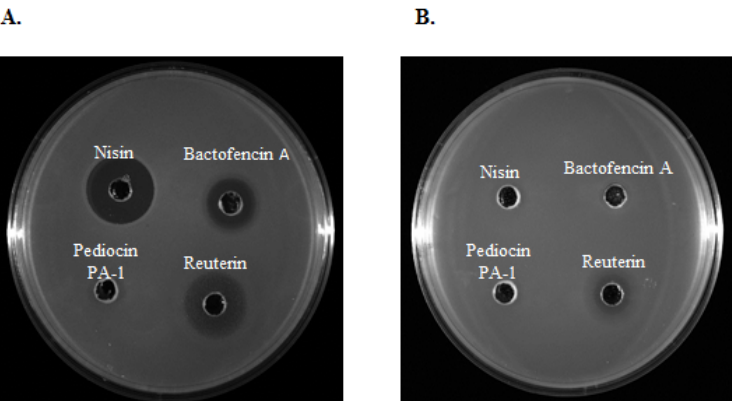
Figure 2. The antimicrobial activity of nisin (250 µ g/mL), bactofencin A (250 µ g/mL), pediocin PA-1 (250 µ g/mL) and reuterin (3.7 mg/mL) against MDR ( A ) Staphylococcus aureus 40709611 [PEN-CEF- FOX-CTX-ERY-CHL-KAN-GEN-PEN/NOV] and ( B ) Staphylococcus aureus 40410425 [VAN-FOX-CTX- ERY-CHL-TET-KAN-GEN].